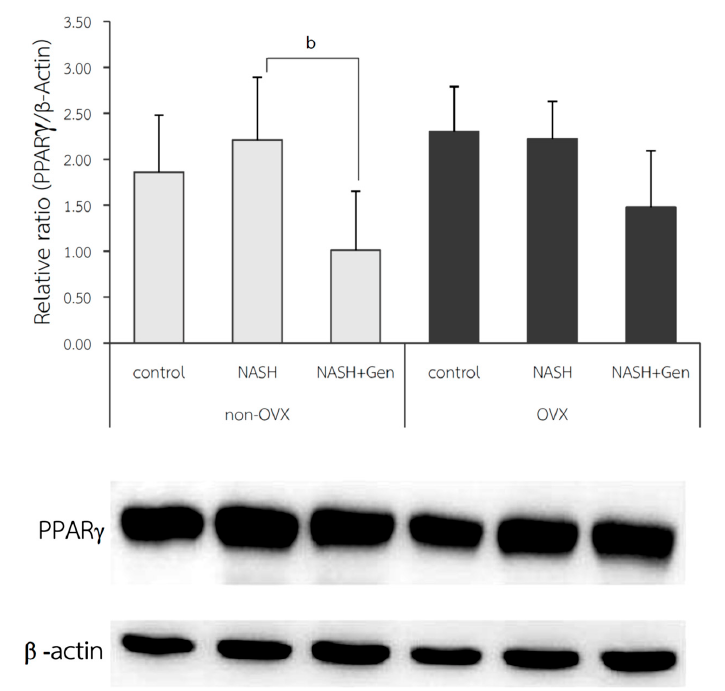
Figure 8. Western blot analysis of PPAR γ protein expression in liver tissue. b: p < 0.05 comparison between NASH and NASH+Gen groups of non-OVX rats.